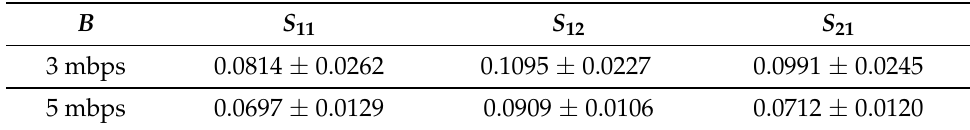
Table 4. The average unfairness index F of the fairness ABR.